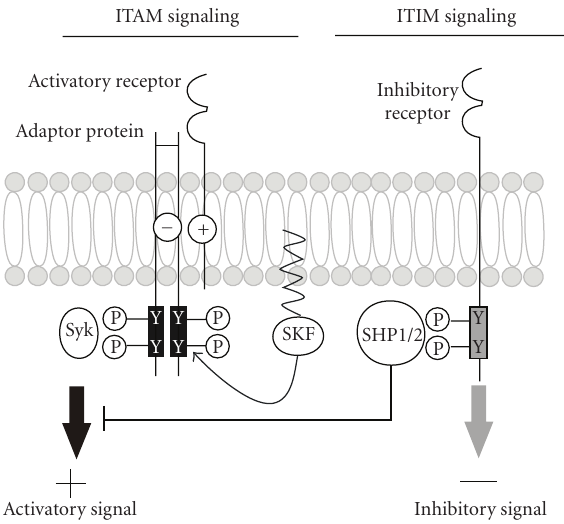
Figure 1: ITAM-/ITIM-signaling cascade. Left side: Upon ligand binding, activatory receptors like TREM2, SIRP β 1, Fc γ RI or Fc γ RIIIA associate with ITAM containing adaptor proteins such as DAP12 or the common γ chains through interactions between charged amino acids ( − / +) within the transmembrane regions of each protein. Subsequently, members of Src kinase family (SKF) phosphorylate tyrosine residues of ITAMs. Phosphotyrosine residues are docking sites for Syk protein kinases that upon activation mediate cellular activation via a number of downstream cascades. Right side: Upon ligand binding, inhibitory receptors like most Siglecs recruit SHP1 and SHP2 which can in turn terminate intracellular signals emanating from ITAM